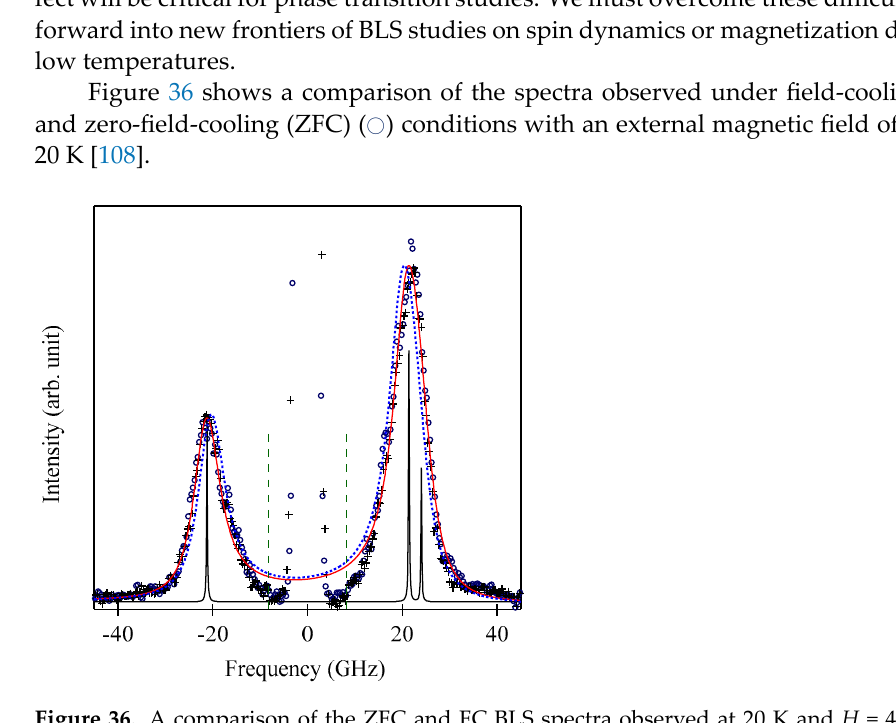
Figure 36. A comparison of the ZFC and FC BLS spectra observed at 20 K and H = 4.0 kOe. The solid line shows numerical fits by the CM theory with the ZFC fitting parameters given in the text. The broken line shows the numerical fit with the same ZFC parameters, except H K = 0. To show the peak positions, the calculated response function S ( Q // , ω ) with a small damping of Γ /2 π = 0.1 GHz is included with a solid line